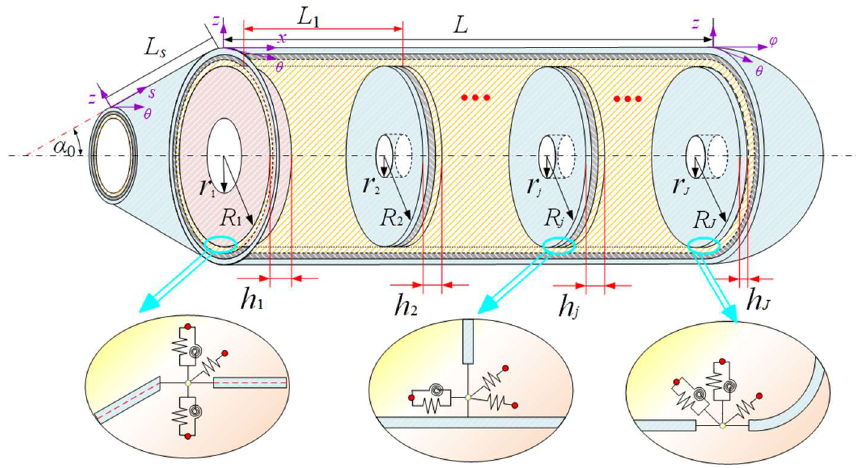
Figure 2. Model diagram of the laminated submarine-like structure.